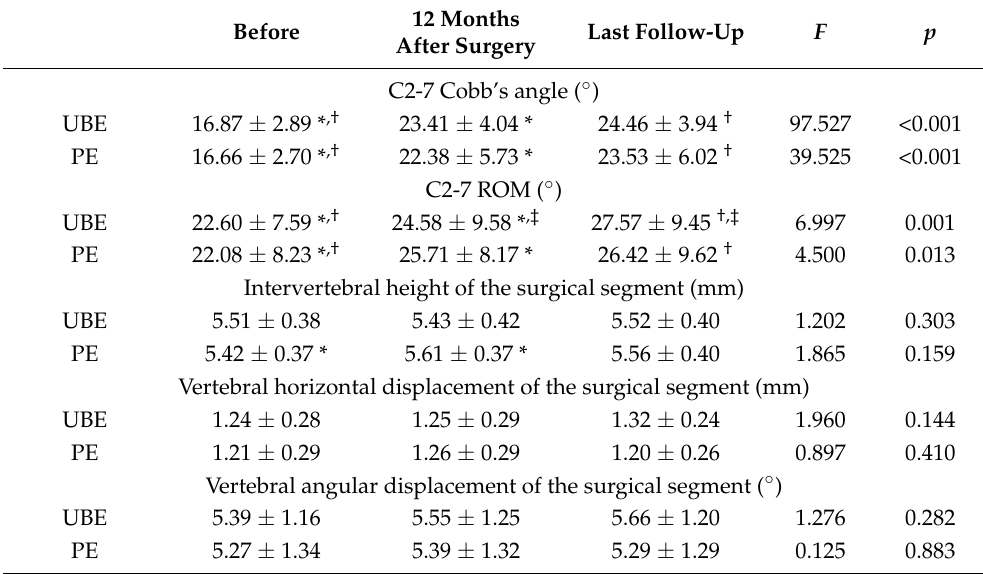
Table 4. Outcomes of imaging measurements.